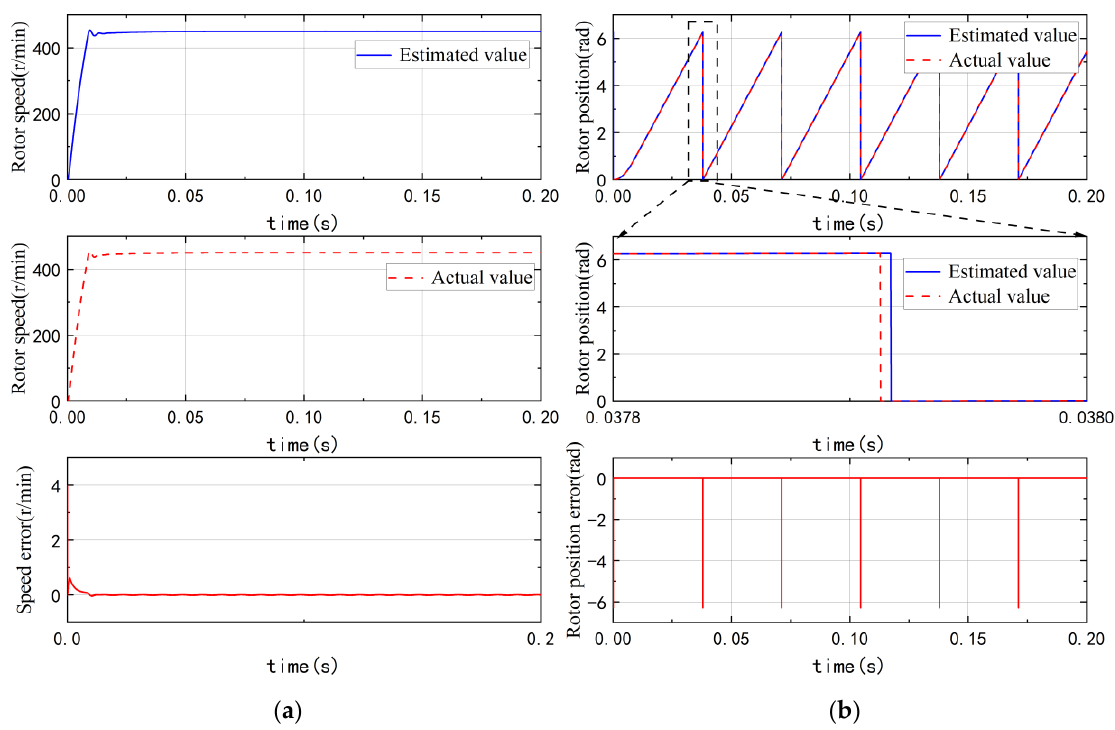
Figure 14. Speed and position estimation results of improved SMO at low speed: ( a ) rotor speed; ( b ) rotor position.